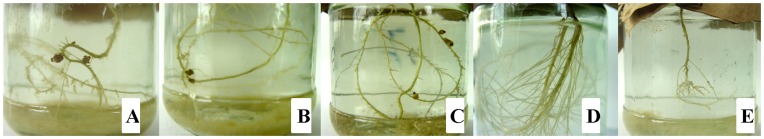
Nodulation of strain D5 inoculated plants.A. Acacia confusa, B. Acacia crassicarpa, C. Acacia mangium, D. Glycine max, and E. Control.